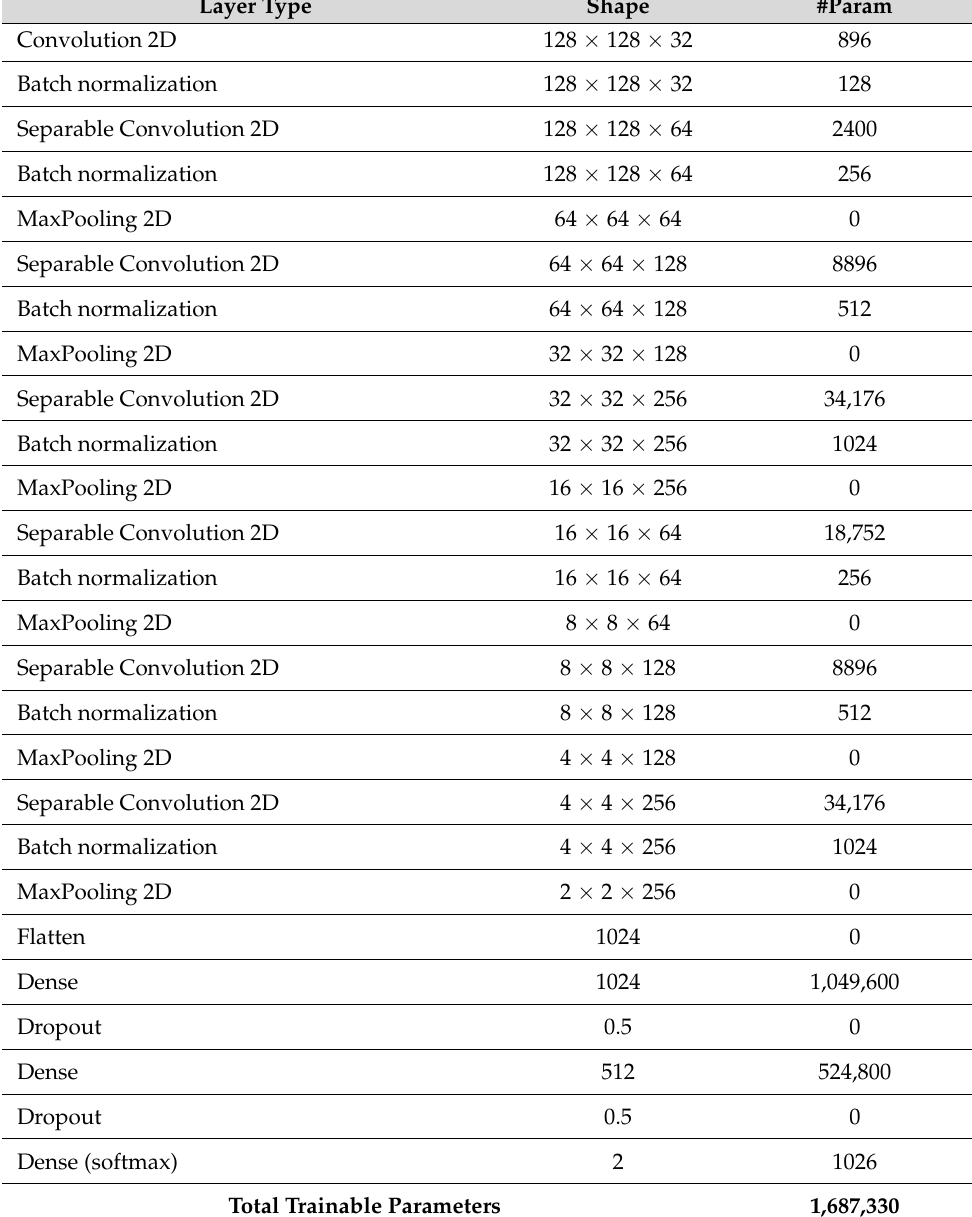
Table 1. SuriNet architecture